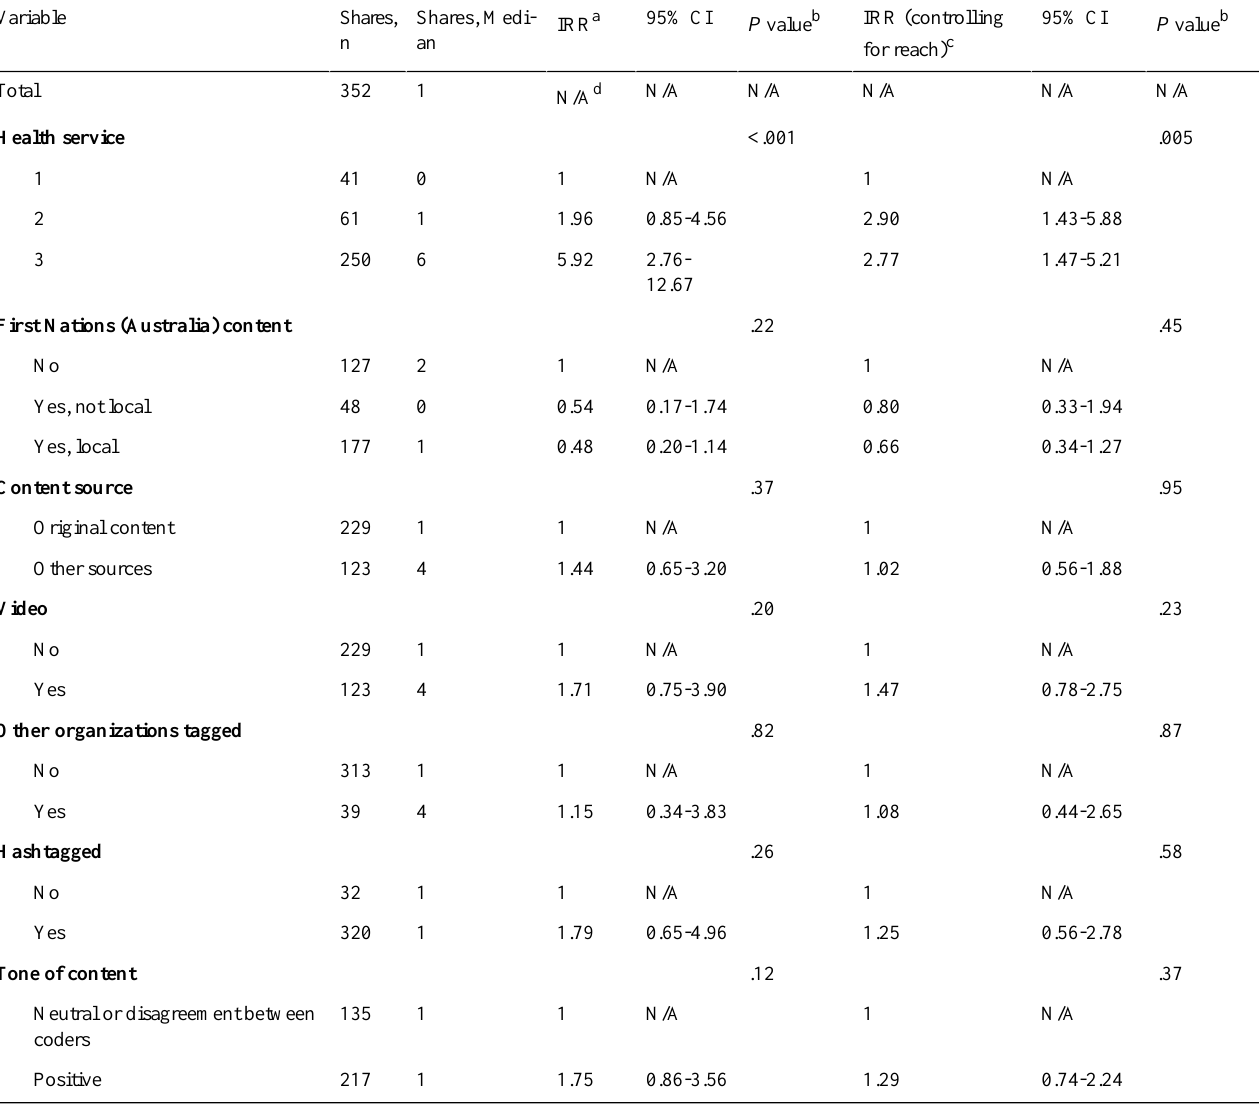
Table 2. Total shares of each type of post, with and without controlling for